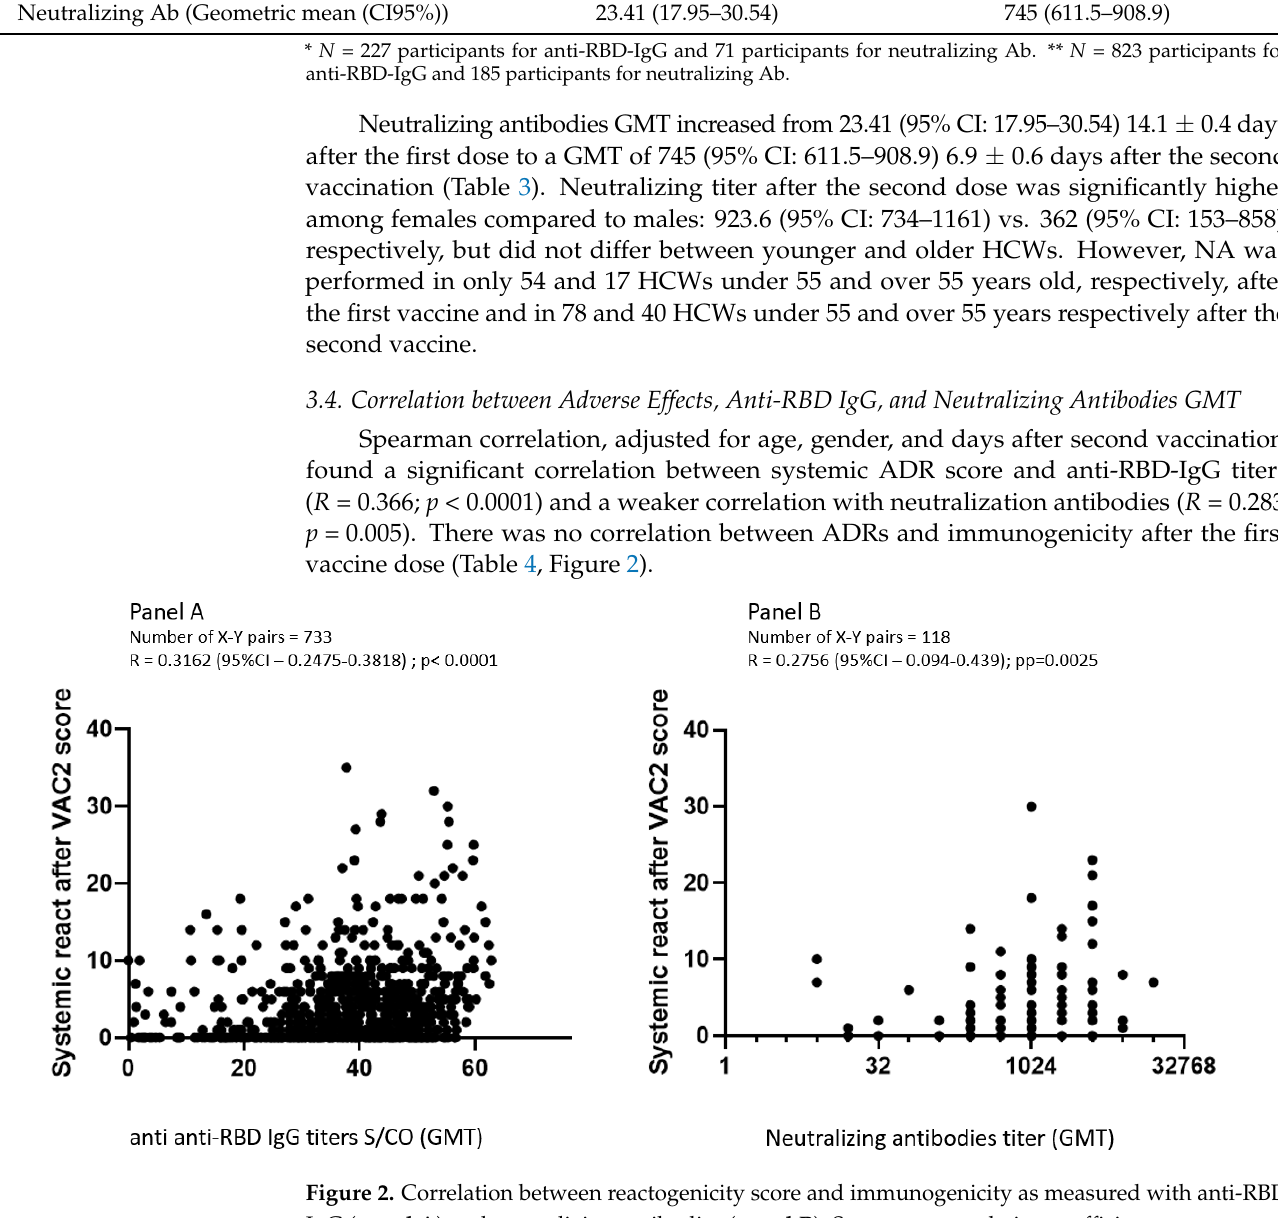
Table 5. Factors associated with adverse events following 1st and 2nd vaccination doses using mul- tivariate logistic regression analysis. After 1st Vaccination ( N = 233) C statistics = 0.719 After 2nd Vaccination ( N = 733) C statistics = 0.751 OR (CI